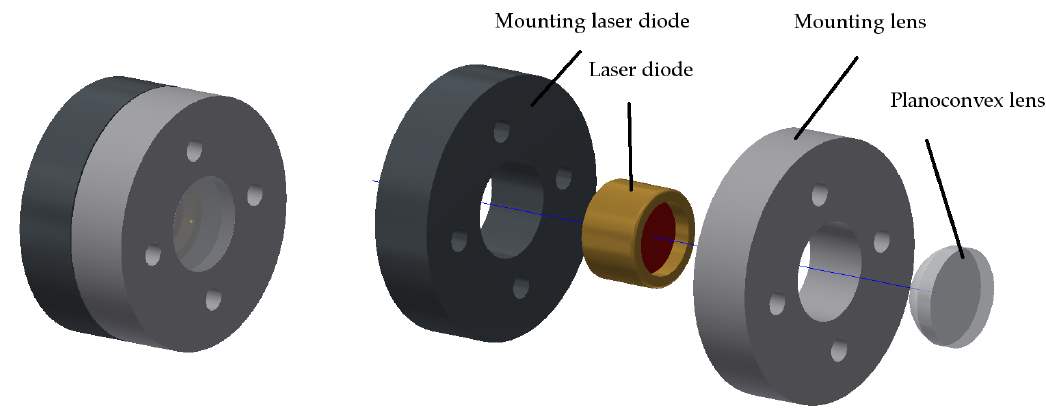
Figure 3. Left projection unit drawing; right projection unit exploded view drawing.